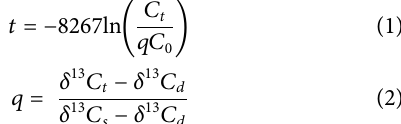
Frontiers in Earth Science |